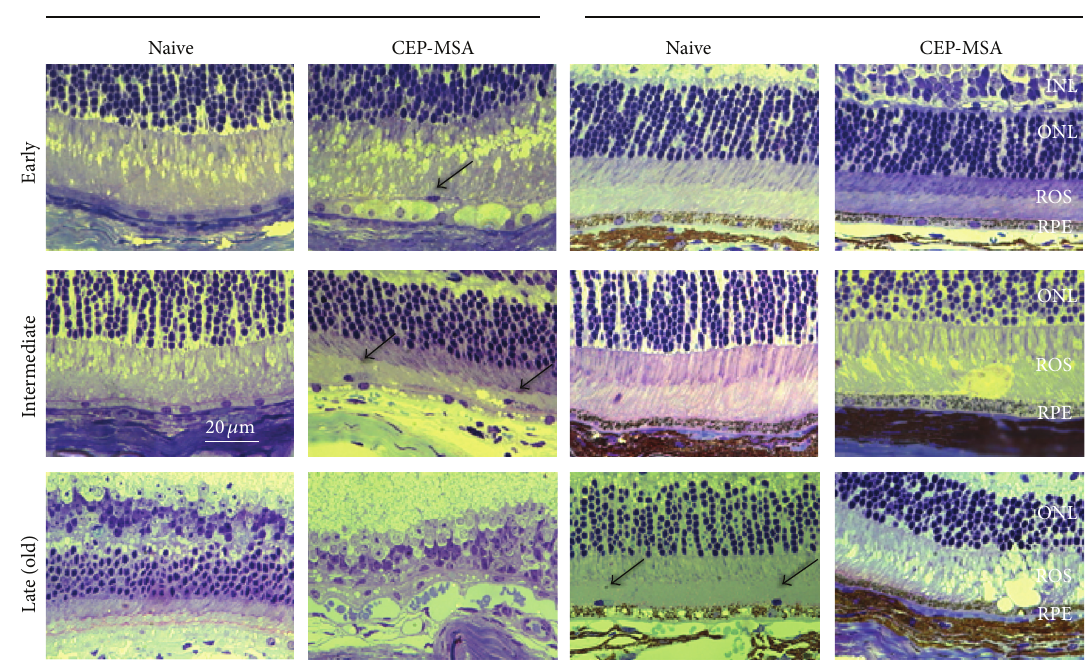
Figure 1: Immunization with CEP-MSA leads to overt retinal degeneration in aged mice that resembles geographic atrophy with loss of photoreceptor cells, particularly in the BALB/c background. Histology of CEP-MSA versus na¨ıve BALB/c or C57BL/6 eyes at different time points postimmunization. The RPE is located at the lower part of each image. The dark arrows show macrophage-like cells. CEP-MSA BALB/c mice show strong pathology since the early time points, starting with swollen RPE cells and leading to massive geographic atrophy at the late time point, including complete loss of the photoreceptor cells. The kinetics of pathology in CEP-MSA B6 mice is slower, but eventually there are focal lesions of the RPE such as vesiculation, as previously reported [21]. Representative images are shown (from 3–5 mice per group per experiment; two or three independent experiments were performed for each strain). INL: inner nuclear layer; ONL: outer nuclear layer; ROS: rod outer segment; RPE: retinal pigment epithelium. Images were obtained using a 63x oil objective, and the scale marker represents a 20 𝜇 m